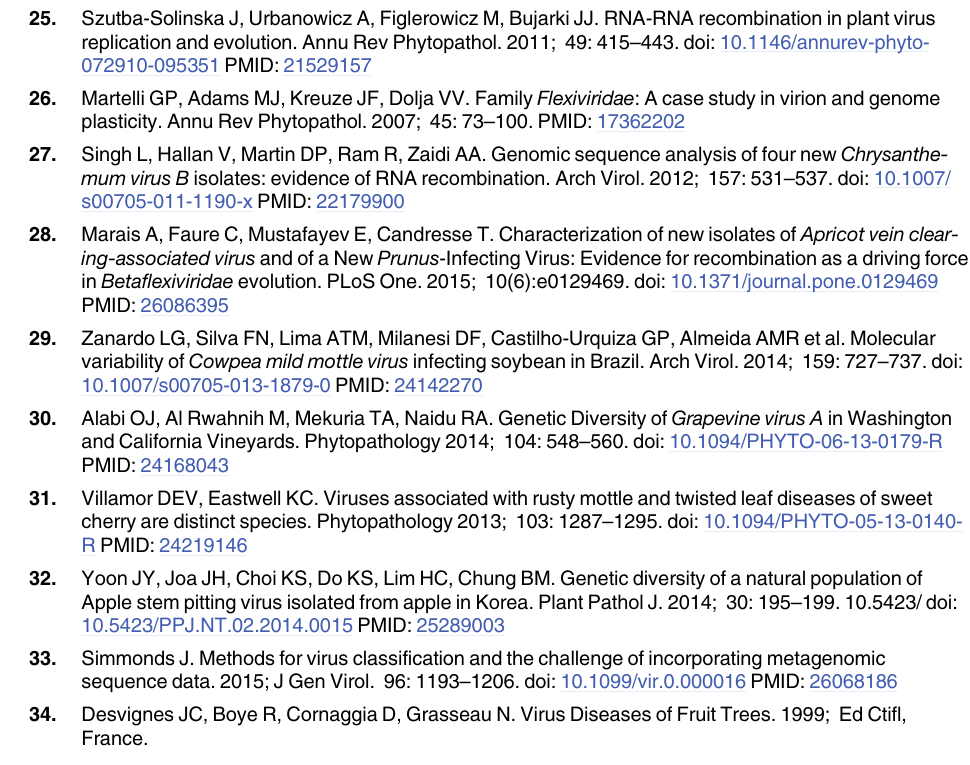
PLOS ONE | DOI:10.1371/journal.pone.0146420 January 7,